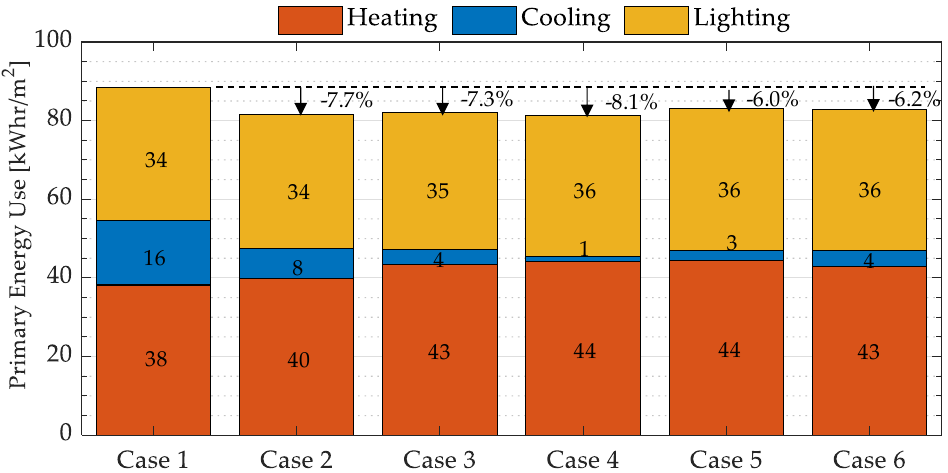
Figure 10. Total annual primary energy use for the various window system cases in Stockholm.